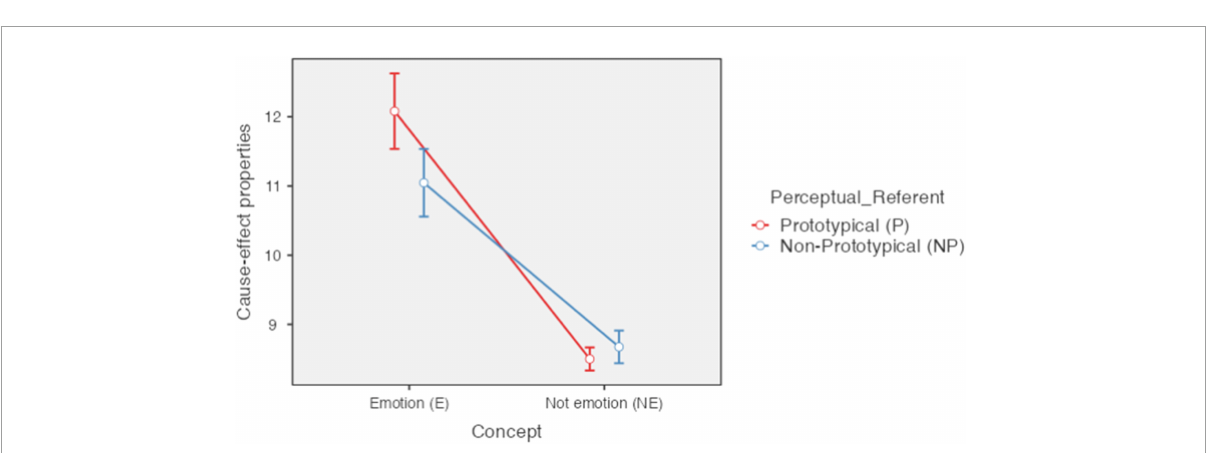
FIGURE5 Number of cause-and-effect properties according to type of concept and type of perceptual referent. Error bars 95% CI; Significant differences between concepts of, basic and secondary emotion (E-P_E-NP); basic emotion and concrete (E-P_NE-P); basic emotion and